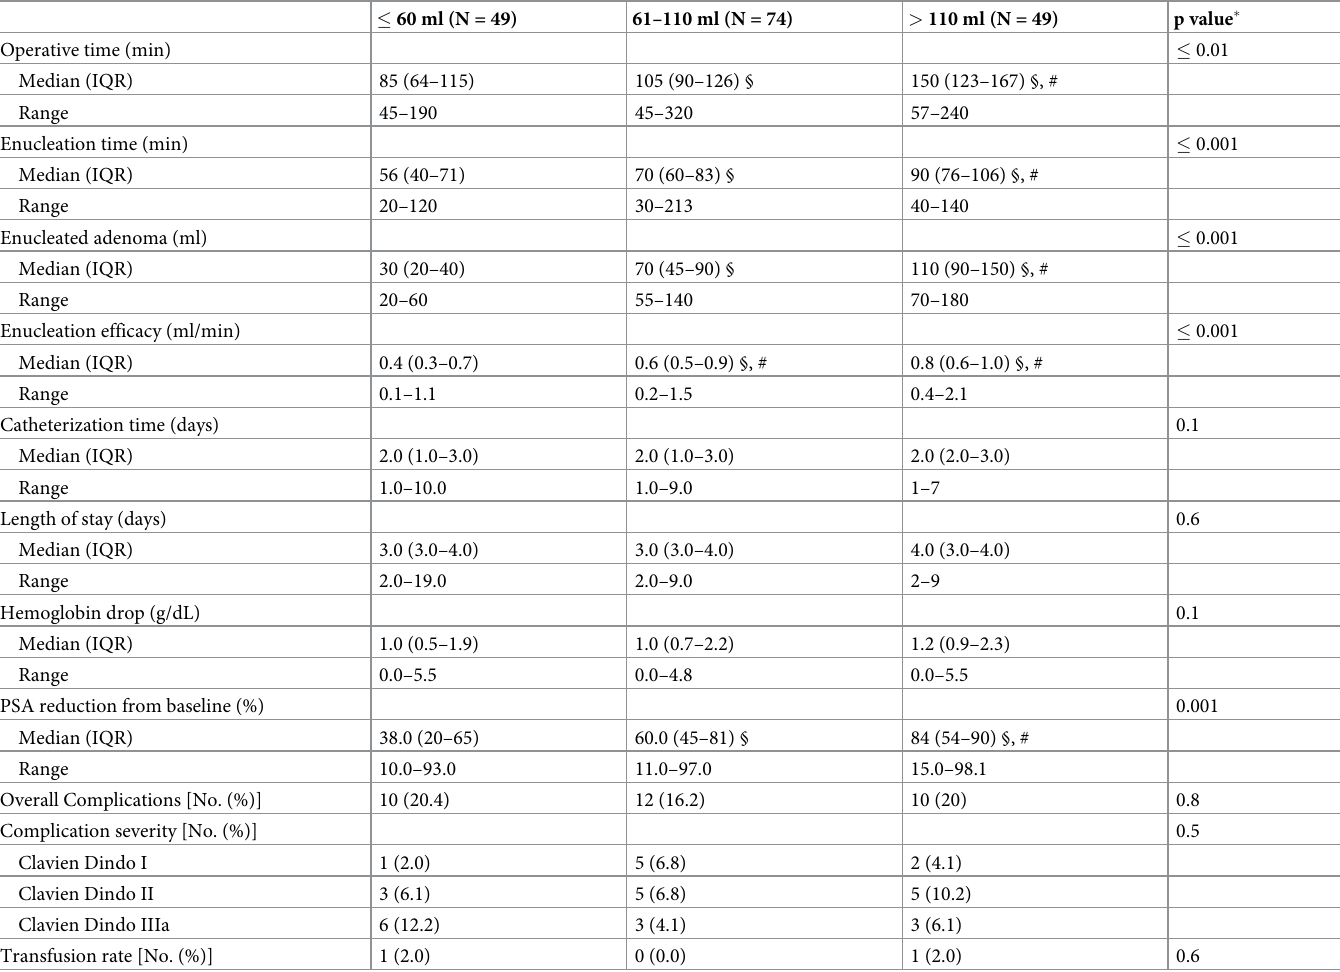
Table 2. Perioperative characteristics of the whole cohort of patients submitted to B-TUEP as segregated according to prostate volume (no. =